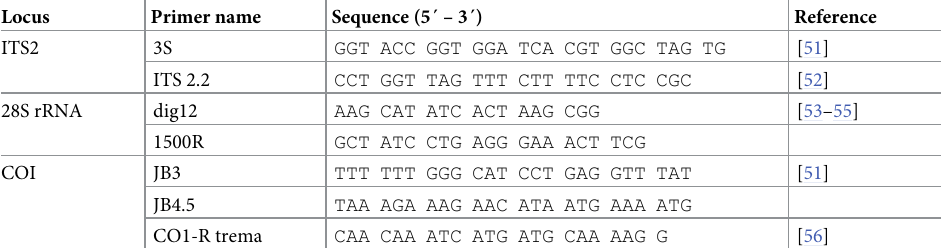
Table 1. Primers used for amplification and sequencing of nuclear and mitochondrial DNA fragments of genes in trematodes examined.